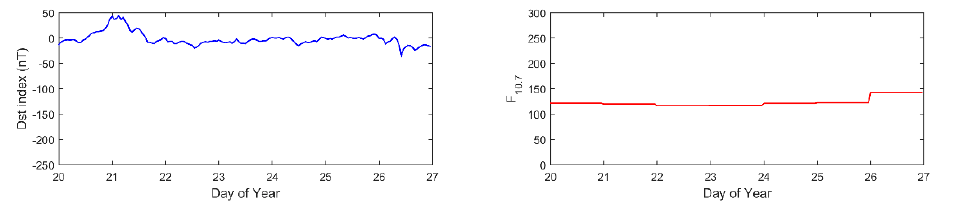
Figure 3. Dst and F 10.7 indices for the period of 020 to 026 of 2015.